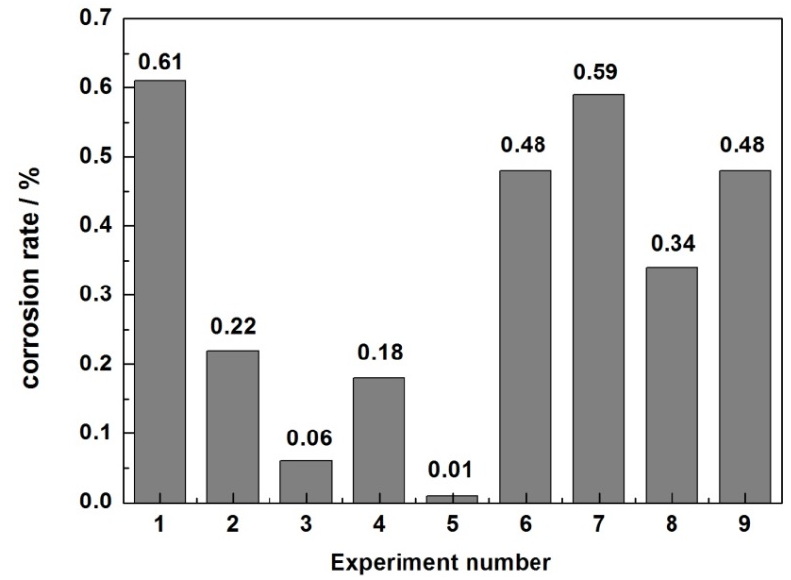
Figure 2. The corrosion rate of each test. Table 3. Range analysis of orthogonal test with thickness as evaluation index.